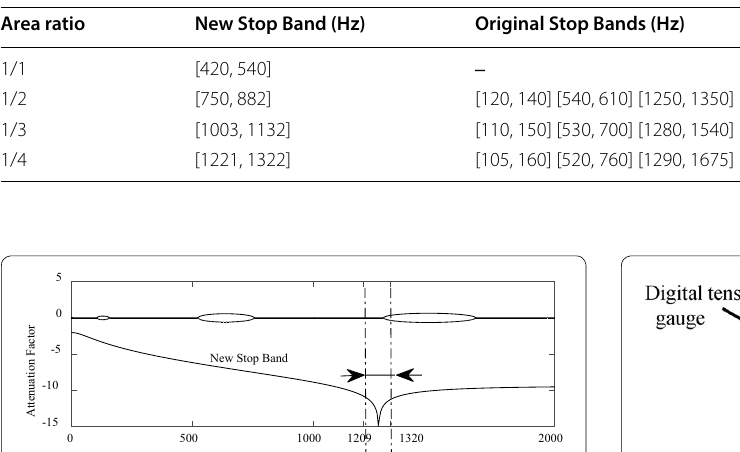
Table 4 Numerical Stop Bands derived from different area ratios